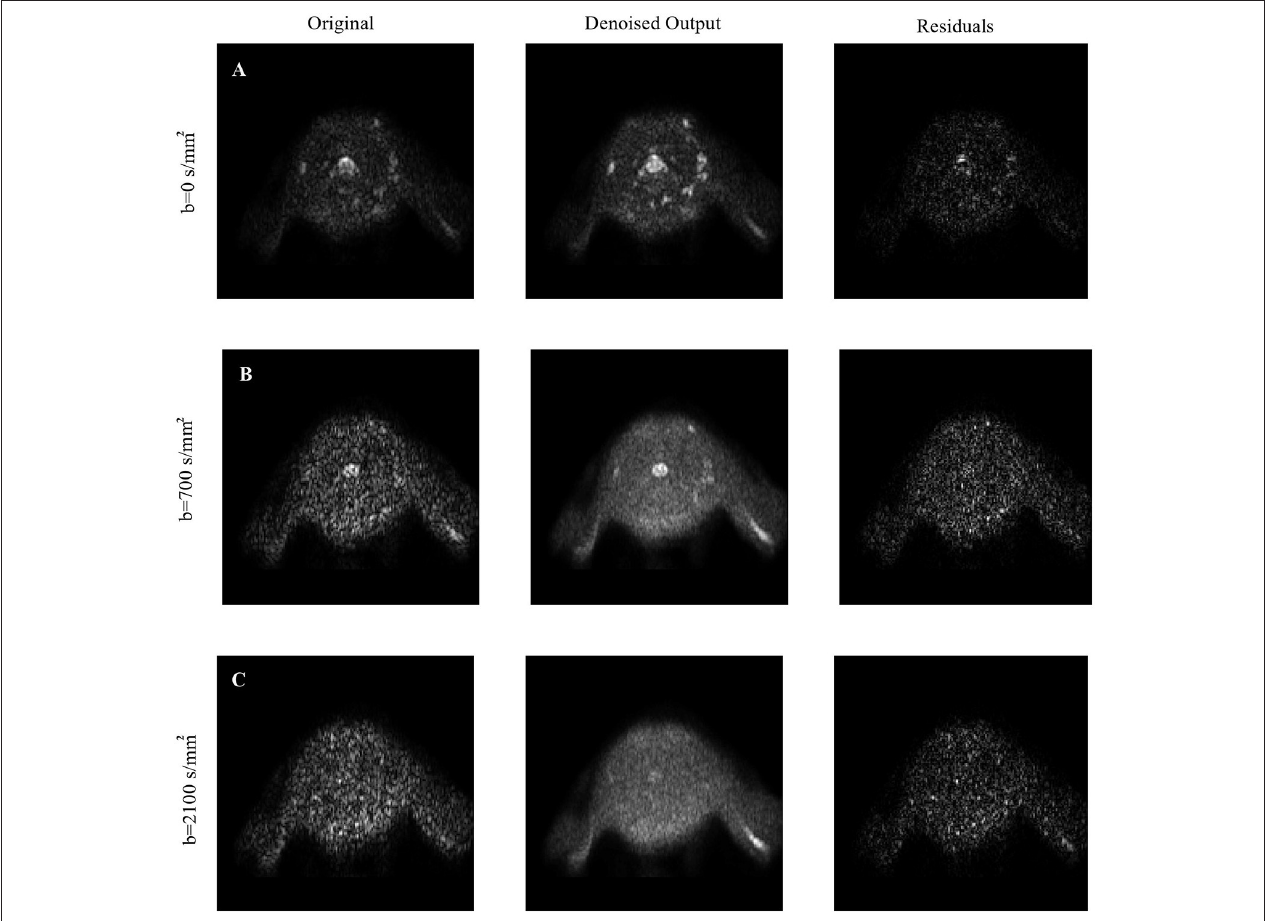
FIGURE 3 | Visual inspection of denoising: The denoising of Patch2Self is compared against the original noisy image along with their corresponding residuals for each (A) b = 0, (B) b = 700, and (C) b = 2,100 s/mm 2 shells, respectively. Notice that Patch2Self does not show any anatomical structure in the corresponding residual plots and likely neither introducing structural